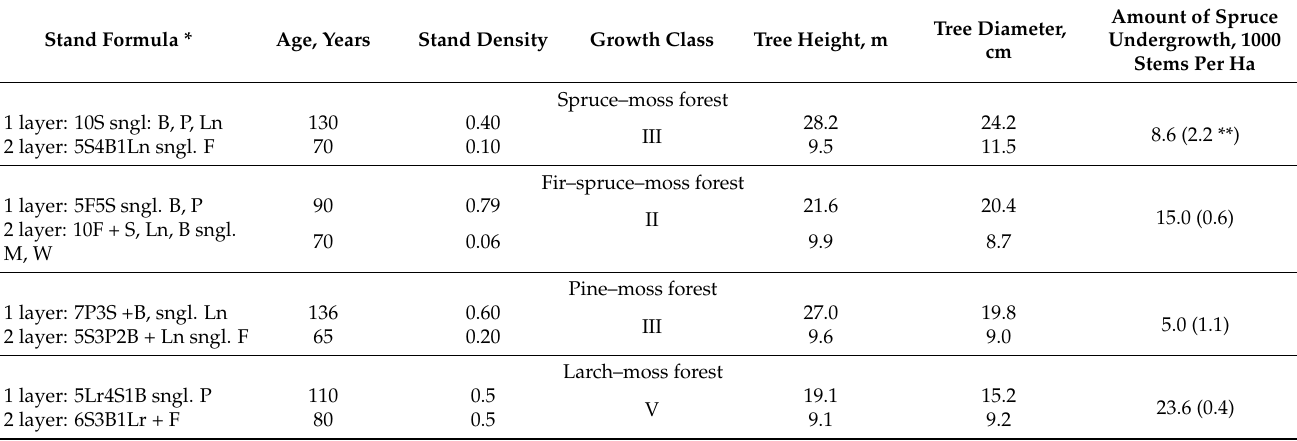
Table 1. Description of the forest sites studied.